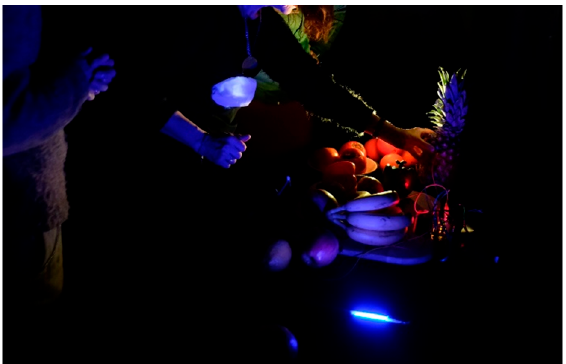
Figure 1. Interactive installation, Cité des Sciences, (2017). Photo: Anne Charignon ©.